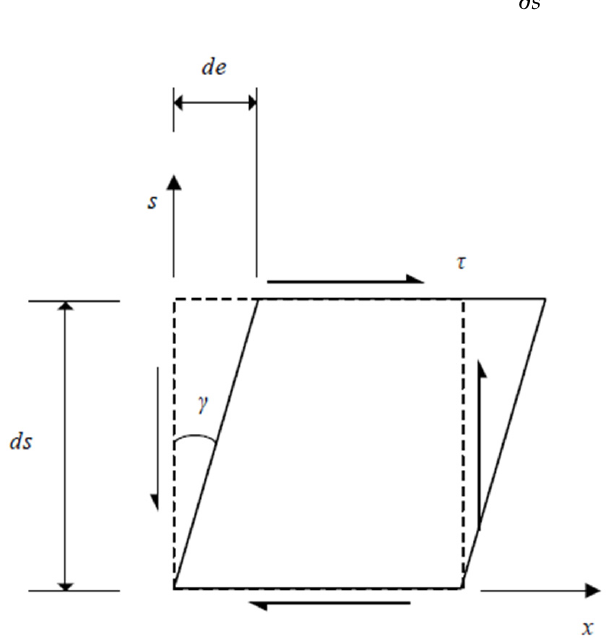
Figure A2. Geometric definition of shear strain.